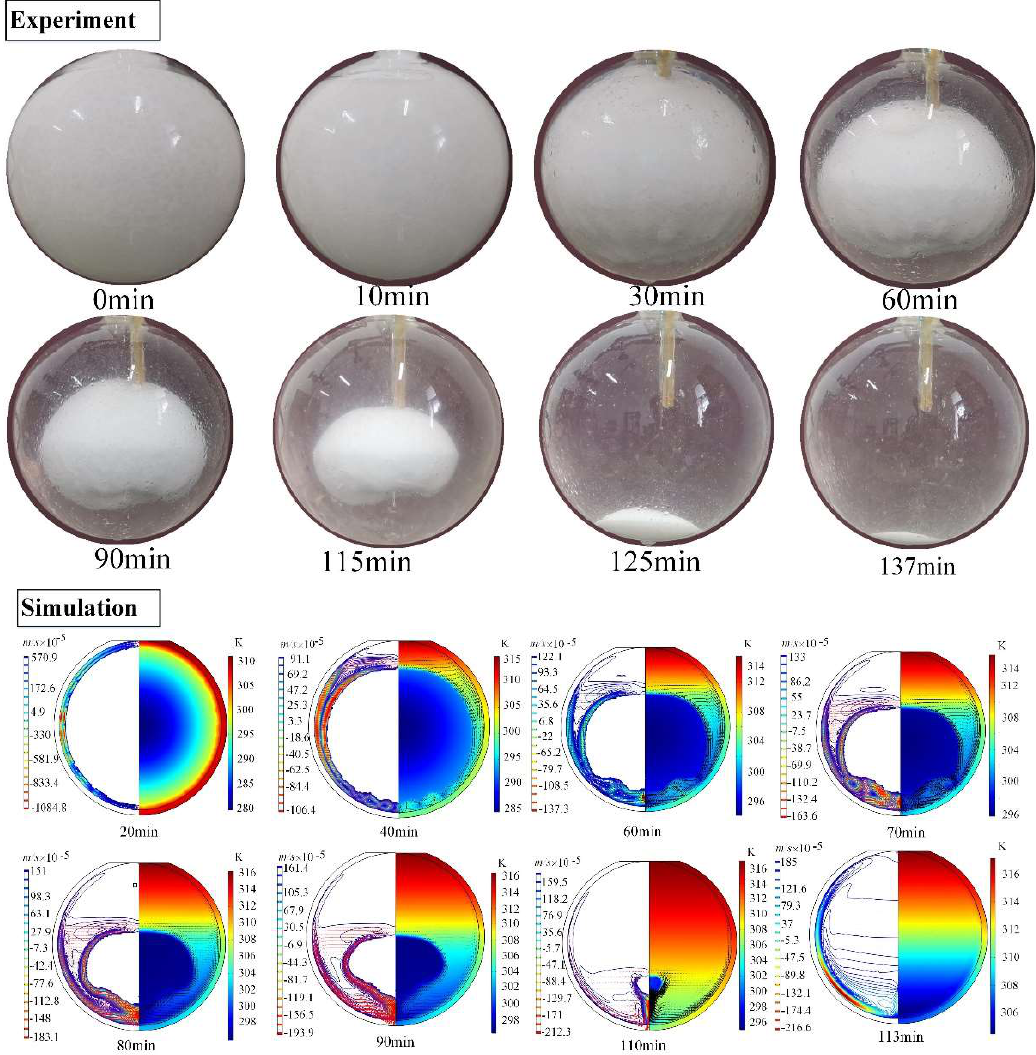
Figure 5. Transient shapes of the solid paraffin for the constrained melting inside the spherical container with R = 31.02 mm and T w = 318.15 K .